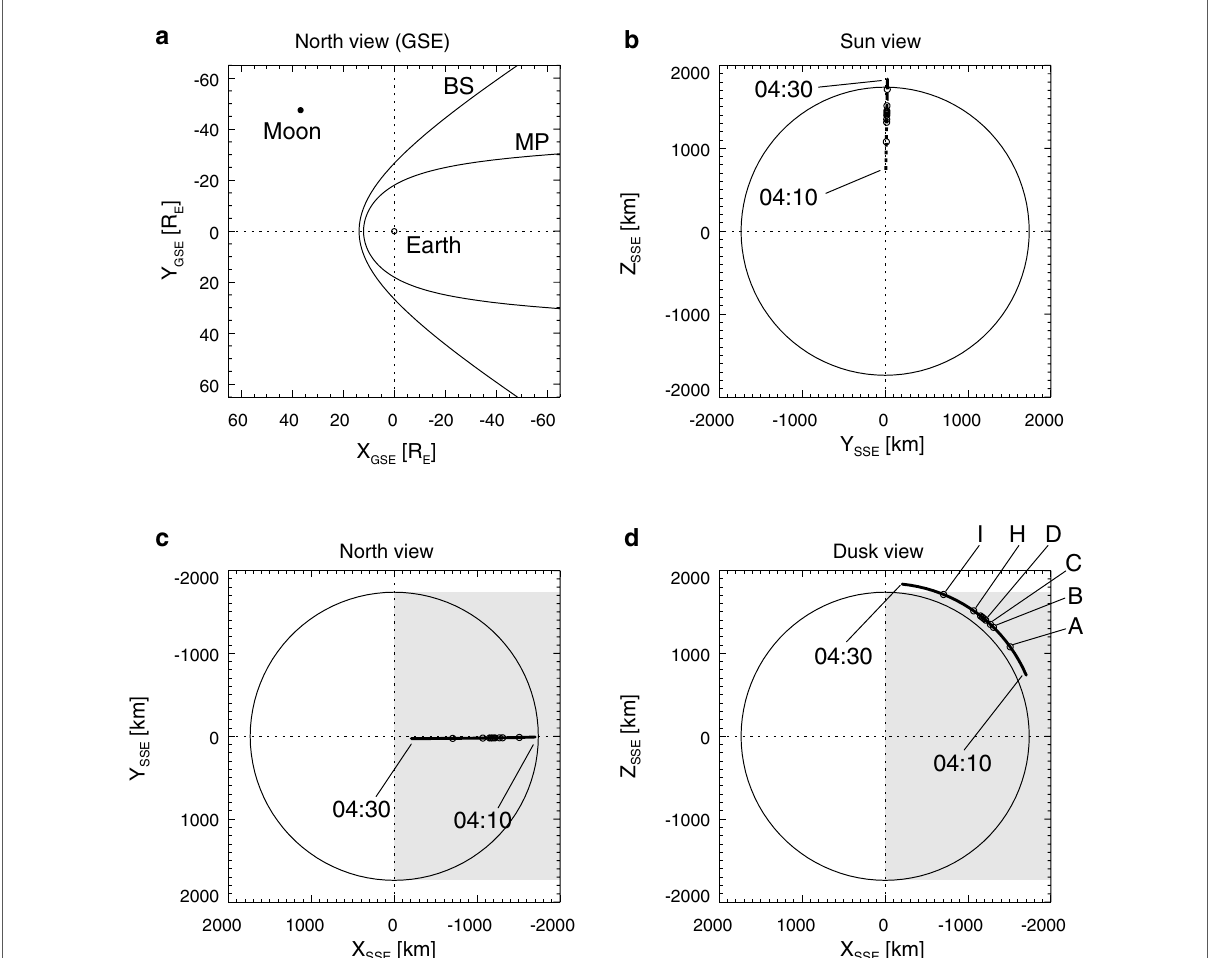
Fig. 2 Kaguya orbit from 04:10 to 04:30 UT on April 2, 2008. a The location of the Moon projected onto the XY plane in the GSE coordinate system, with typical locations of the Earth’s magnetopause (MP) for the dynamic pressure of 0.7 nPa (Shue et al. 1998) and the bow shock (BS) (Slavin and Holzer 1981). b – d Kaguya orbit in the SSE coordinate system. The spacecraft locations at the times when the electron pitch-angle distributions in Fig. 3 were taken are also indicated by black points ( a – i